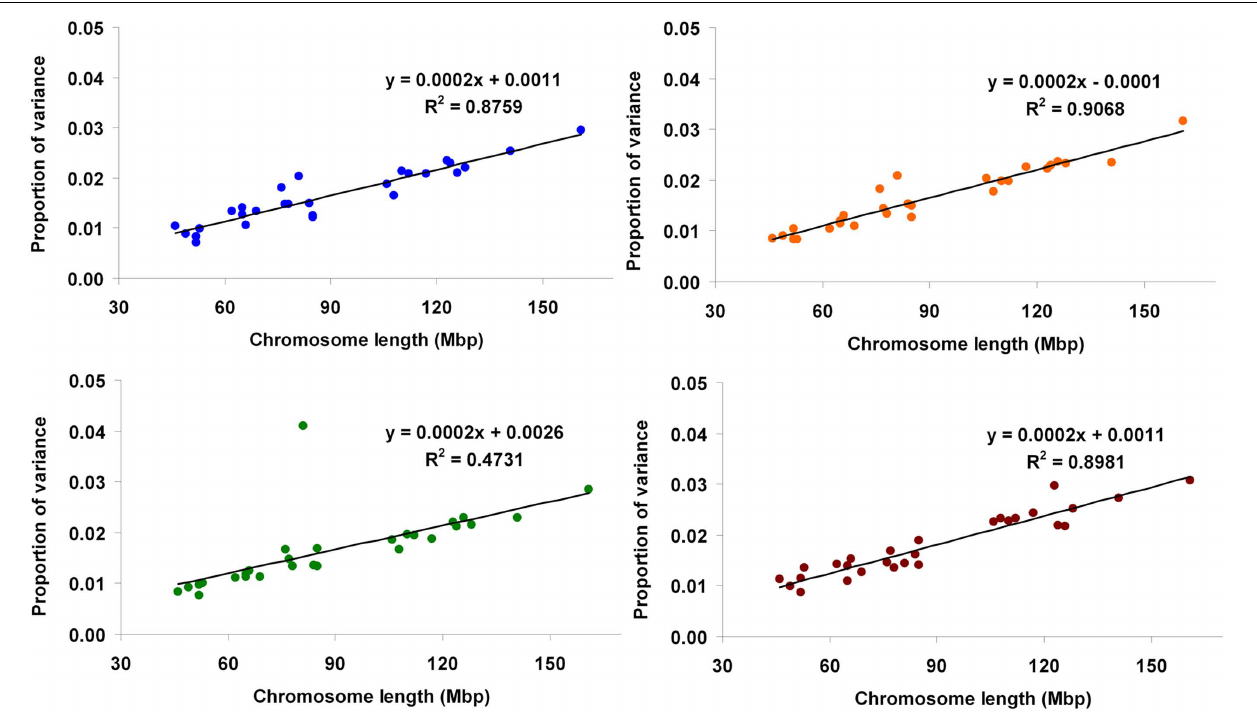
FIGURE 2 | Proportion of genetic variance for milk yield (blue), protein percentage (orange), fat percentage (green), and somatic cell score (brown) explained by each autosome (estimated using method 1) against physical length of the chromosome.